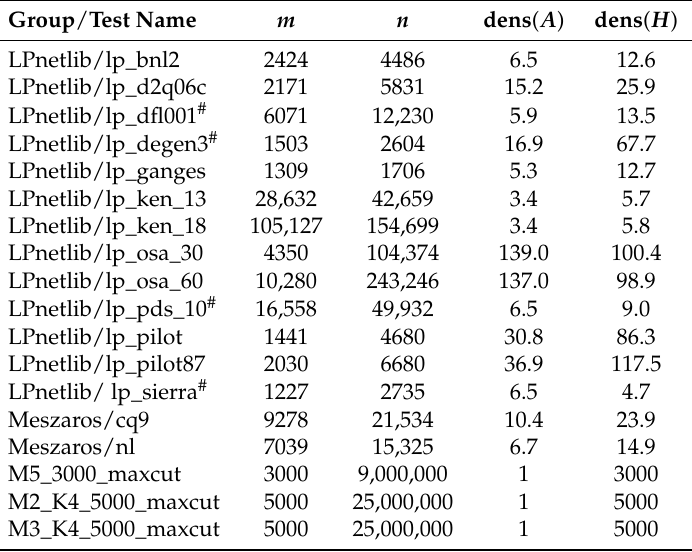
Table 2. Test problems with H = A Θ A T : source and name of A ∈ IR m × n , dimension of A , density of A ( dens( A )) and density of H (dens( H